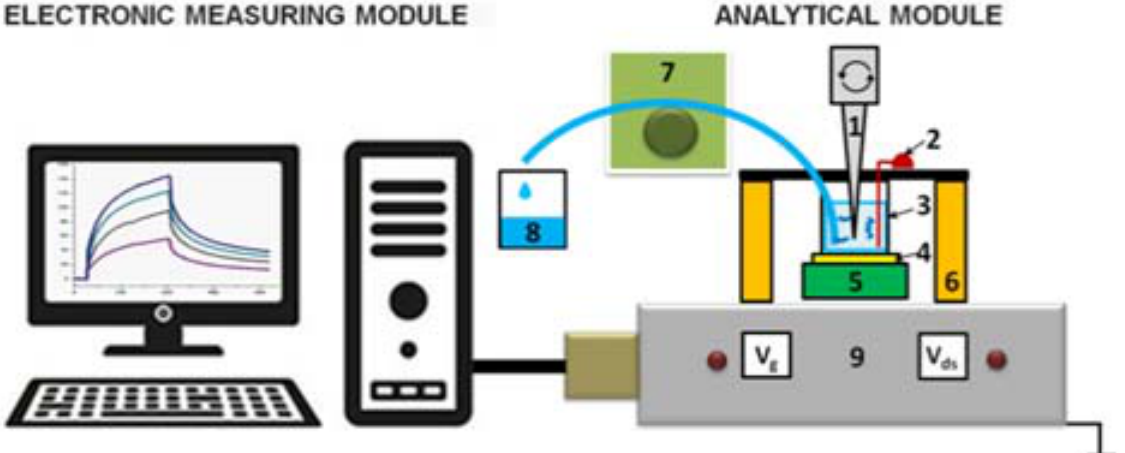
Figure 1. Schematic of the nanoribbon detector. Numbers indicate the main elements of the detector: 1—stirrer, 2—Pt electrode, 3—measuring cell, 4—silicon-on-insulator nanoribbon (SOI-NR) sensor chip, 5—chip holder, 6—measuring cell holder, 7—peristaltic pump, 8—waste container, 9—ten-channel data collection and storage system.